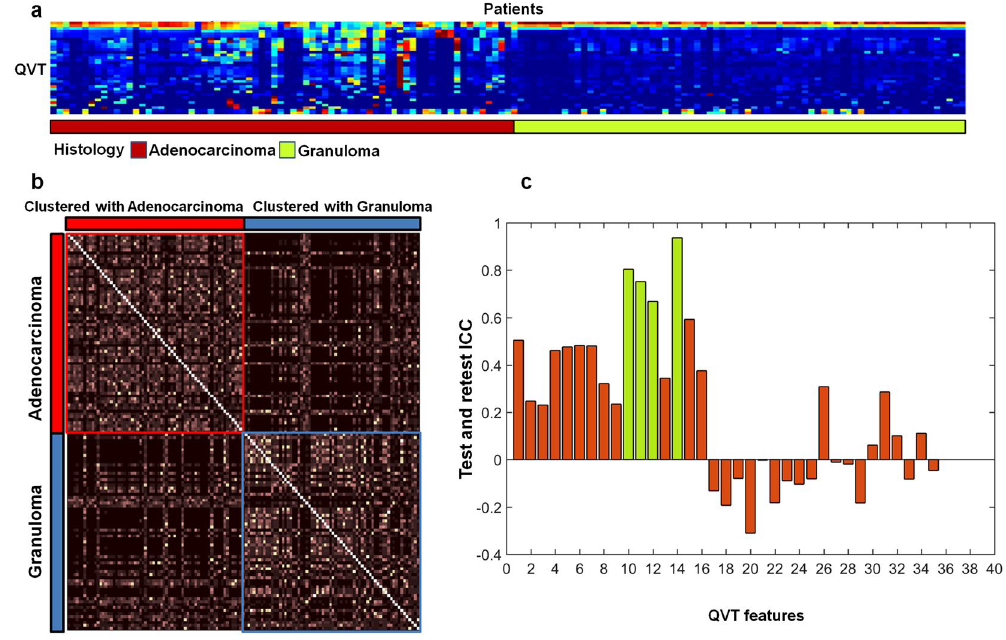
Figure 2. ( a ) QVT heatmap showing differential expression for the adenocarcinomas and granulomas within D 1 . X axis (columns) corresponds to the patients and Y axis (rows) corresponds to the most discriminating QVT features. Colors represent feature values normalized between [0, 1]. A number of identified QVT features showed significant differential expression between the adenocarcinomas and granulomas for the patients in D 1 . ( b ) Two dominant clusters emerge by applying ensemble clustering of the QVT features for the patients in D 1 . Performing iterative clustering with different parameters and counting the co-occurrences of the patient pairs falling into a same cluster resulted in roughly 75% of the cases within each cluster being assigned to a single category. Pixel intensities correspond to the co-occurrence of a pair of patients clustered within the same group. ( c ) The ICC values for all 35 QVT features as assessed on the RIDER dataset. ICC > 0.7 corresponds to highly reproducible features. ICC > 0.4 suggests moderate